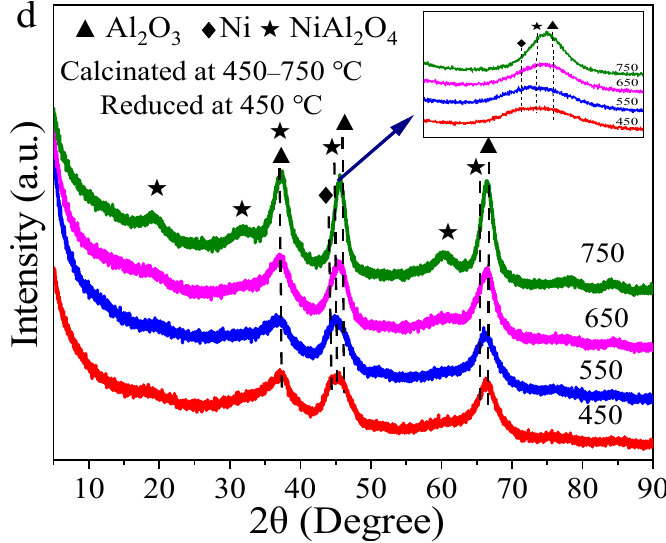
Figure 5. XRD patterns of Ni 10 Mo x Al catalysts ( a ) before and ( b ) after reduction at 450 °C; Ni 10 Mo 10 Al catalysts calcined at 450–750 °C ( c ) before and ( d ) after reduction at 450 °C. Figure 5c shows the XRD spectra of Ni 10 Mo 10 Al catalysts calcined at different tem- peratures (450–750 ◦ C). With the increase in the calcination temperature, the diffraction peaks of the γ –Al 2 O 3 and NiAl 2 O 4 phases gradually became intense and narrow. The new diffraction peaks around 2 θ = 19.1, 31.4 and 60.9 ◦ , which were the overlapping peaks of NiAl 2 O 4 and Al 2 O 3 , were observed when the catalyst was calcined under 750 ◦ C. Com- pared with the diffraction peaks of Al 2 O 3 calcinated at 750 ◦ C, it can be concluded that the new diffraction peaks are mainly due to the formation of NiAl 2 O 4 at a higher calcination temperature [31,32]. Regarding the reduced Ni 10 Mo 10 Al catalysts, as shown in Figure 5d, the intensity of the characteristic peaks was attributed to Ni 0 decreases, while the peaks of the NiAl 2 O 4 phase gradually became intense and narrow with the enhancement of the calcination temperature, demonstrating that the higher calcination temperature favors the formation of NiAl 2 O 4